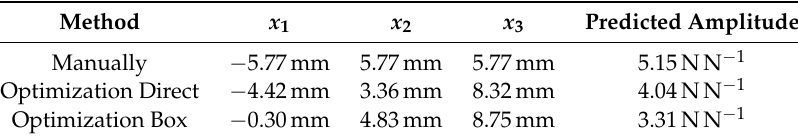
Table 1. Designs, optimized by different